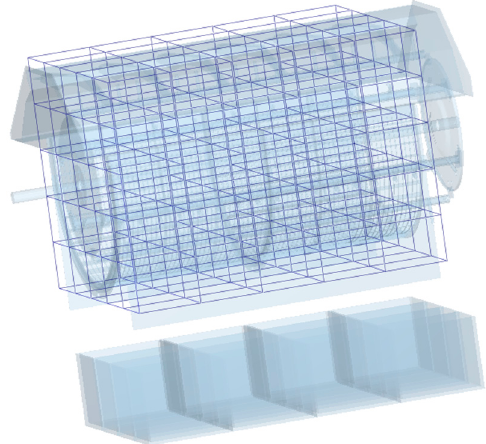
Figure 9. Grid bin group 1.